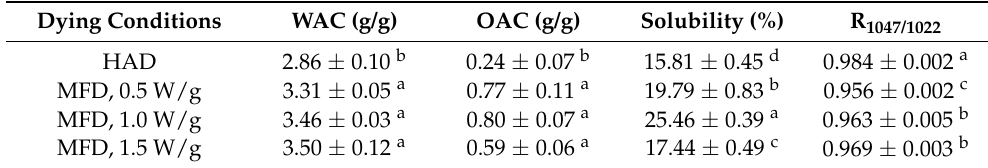
Table 2. Functional properties and R 1047/1022 value of dried yam flour processed by HAD and MFD. Dying Conditions WAC (g/g) OAC (g/g) Solubility (%) R 1047/1022 HAD 2.86 ± 0.10 b MFD, 0.5